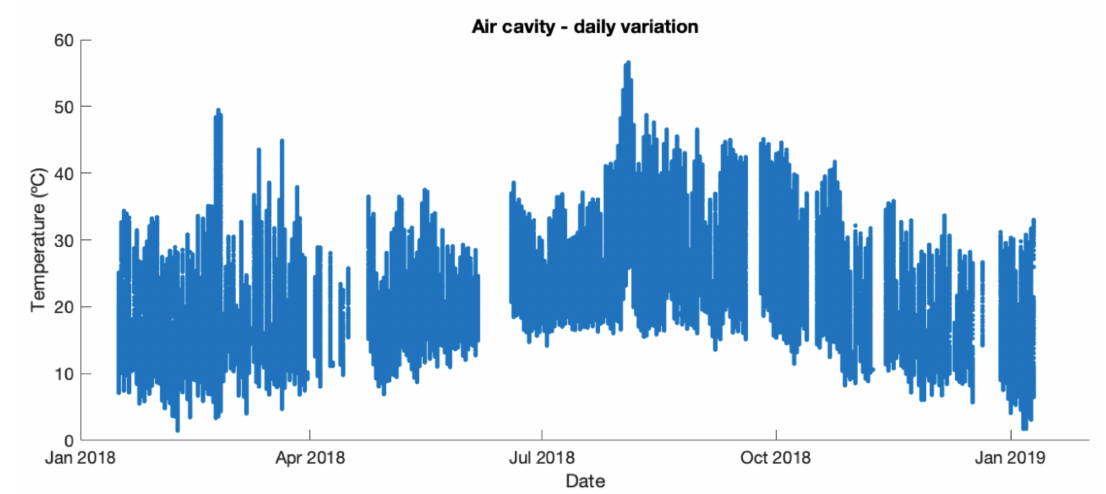
Figure 7. Yearly air cavity